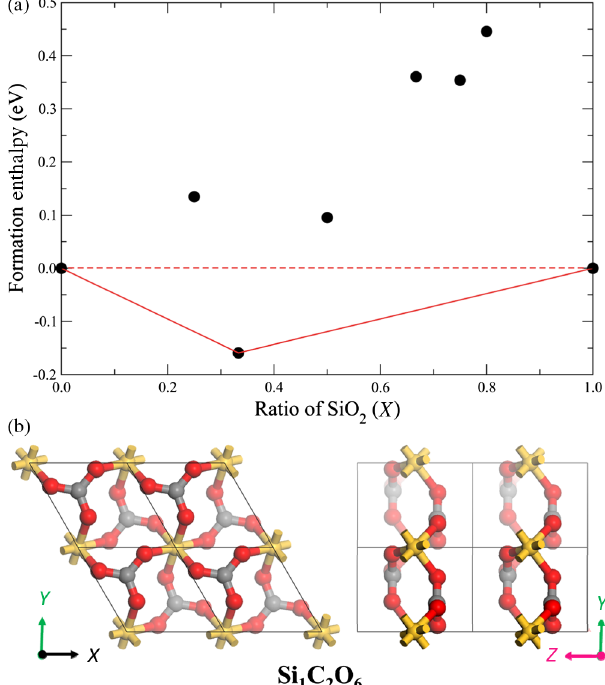
FIG. 3 (color online). (a) The formation enthalpy of the lowest- enthalpy structures of Si x C 1 − x O 2 under 20-GPa pressure as a function of x . (b) The detailed structure of the most stable structure of Si 1 C 2 O 6